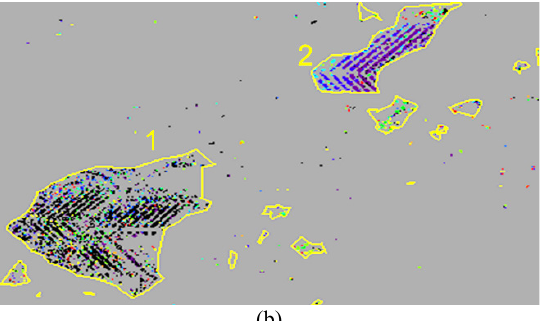
Figure 9. Spatiotemporal changes in patch 3 (Figure 7). (a) EBC points are clustered as segment 1 (new high-rise building) and segment 2 (new storeys). (b) Mean and SD of emergence dates (unit: bd defined in Table 1). Segment 1: Mean, 18.4; SD, 2.7. Segment 2: Mean, 19.1; SD,